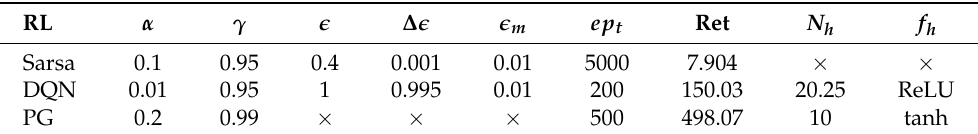
Table A1. Parameter for the training of the different RL agents: α is the learning rate, γ is the discounting factor, (cid:101) is the value for the (cid:101) -greedy method, ∆ (cid:101) is the decay (multiplicative for DQN and subtractive for PG), (cid:101) m is the minimum value reachable by (cid:101) , ep t is the number of the episodes for the training, Ret is the average return after the training, N h is the number of hidden nodes and topology of the network, f h is the activation function. When a parameter was not considered, we represented this situation with the symbol × .